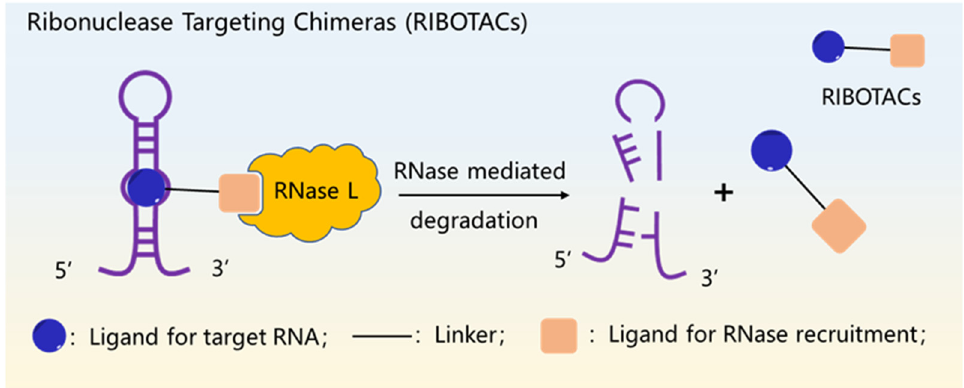
Figure 4. The mechanism of RIBOTACs.